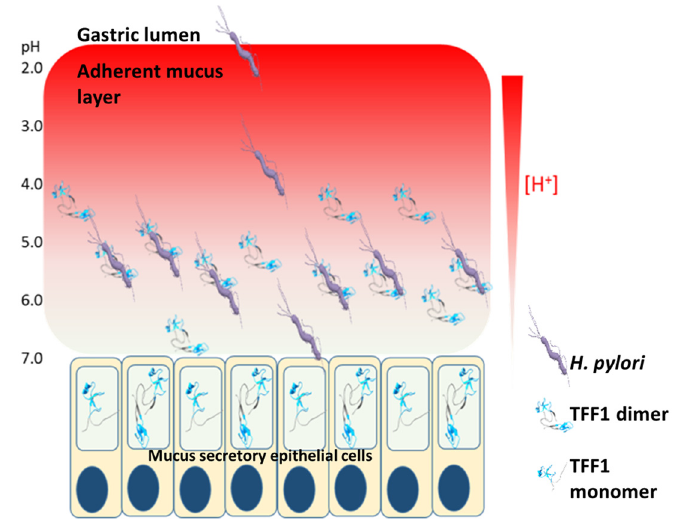
Figure 4. Potential biological e ff ect of H. pylori interaction with TFF1. TFF1 is localised within mucous granules in mucus-secreting cells and is secreted from the cells into the adherent mucus layer. TFF1 is concentrated close to the epithelial surface at the higher pH end of the pH gradient. Upon entering the stomach, H. pylori travel through the mucus layer to escape the acidic environment present in the gastric lumen. H. pylori reside in a niche close to the gastric epithelium where the pH is near neutral. Binding of H. pylori to TFF1 occurs best at pH 5.0–6.0 and may anchor H. pylori deep in the mucus layer close to the epithelial cells. This interaction may limit the number of organisms that reach and interact with the epithelial cells, thus reducing the inflammatory response.